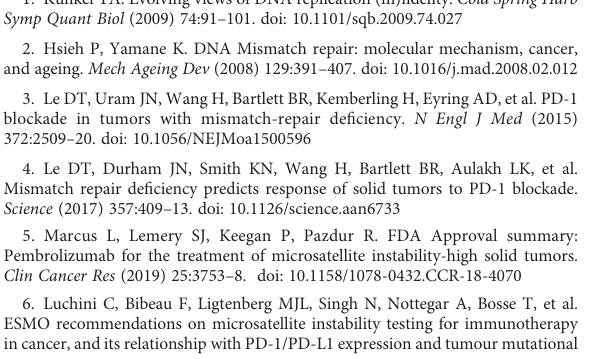
SUPPLEMENTARY TABLE 4 Properties of the clinical samples used in the study. SUPPLEMENTARY FIGURE 1 (A) Score obtained with MSIdetect, using WES homopolymers in colorectal, stomach and endometrial cancer. Each point corresponds to one sample colored by reported MSI status (refer to legend in the fi gure). Receiver Operating curves and corresponding Area Under the Curve (AUC) values (in the inset) for endometrial (B) , colorectal (C) and stomach (D) cancers for MSI classi fi cation by MSIdetect, mSIGNS and MANTIS using WES homopolymers given the MSI status reported by TCGA. SUPPLEMENTARY FIGURE 2 Distribution of the MSIscore for microsatellite instability high (MSI-H, red) and stable (MSS, blue) samples in the training set using the different homopolymers combinations in endometrial (A) , colorectal (B) and Stomach (C)